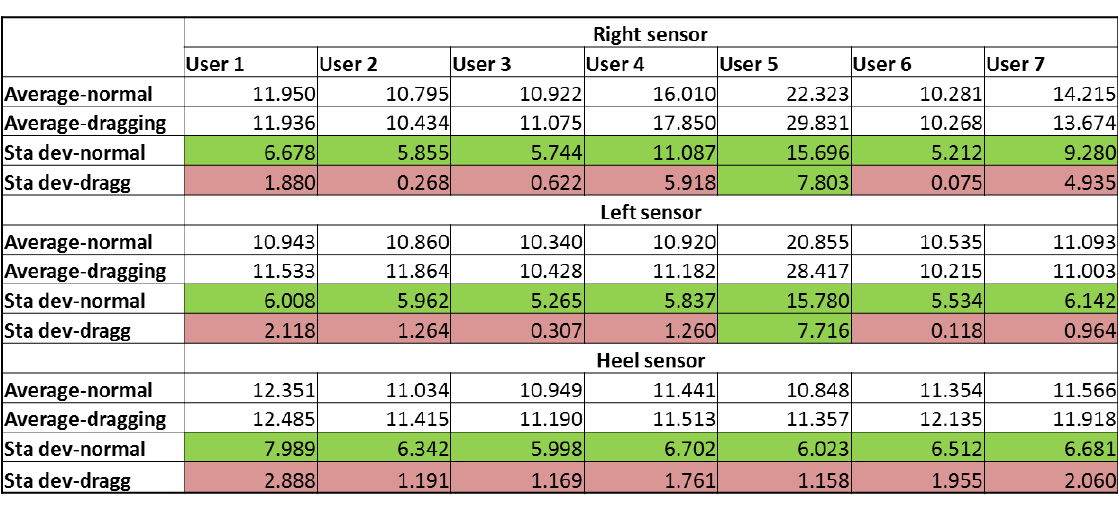
Table 5. Average and standard deviation of the pressure